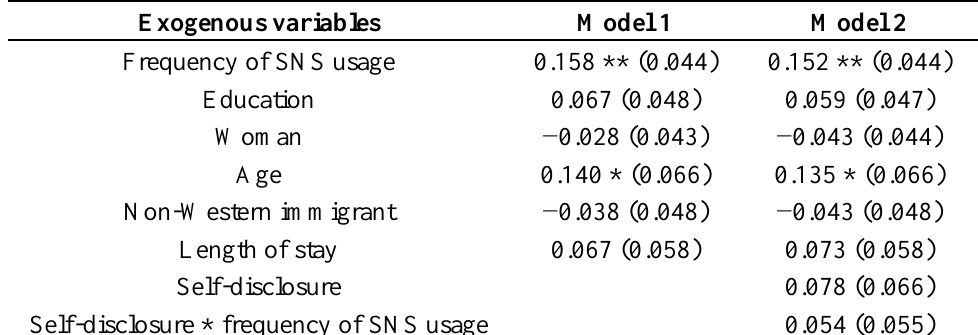
Table 2. Path model predicting satisfaction with social relationships (standardized coefficients and standard